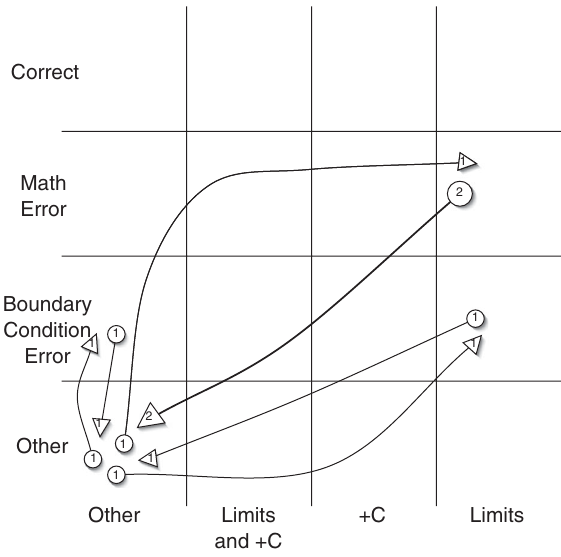
FIG. 8. Sample consistency plot (i.e., not actual data) showing examples of attractors, starbursts, circulation, and void.